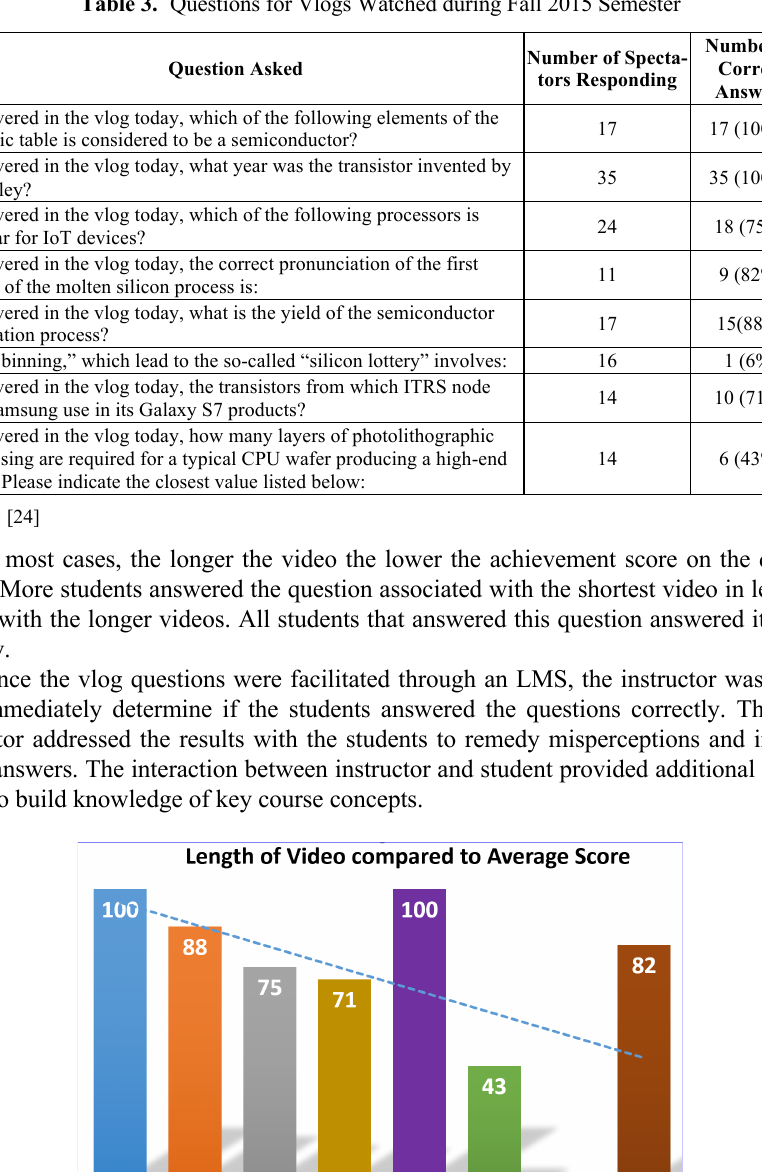
Table 3. Questions for Vlogs Watched during Fall 2015 Semester